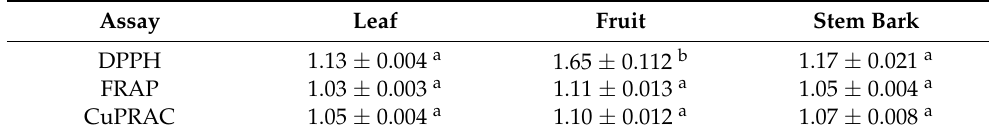
Table 3. The antioxidant power of P. hybrida ’s extracts according to three different methods (DPPH, FRAP, and CuPRAC), expressed in EC 50 (mg/mL). Assay Leaf Fruit Stem Bark